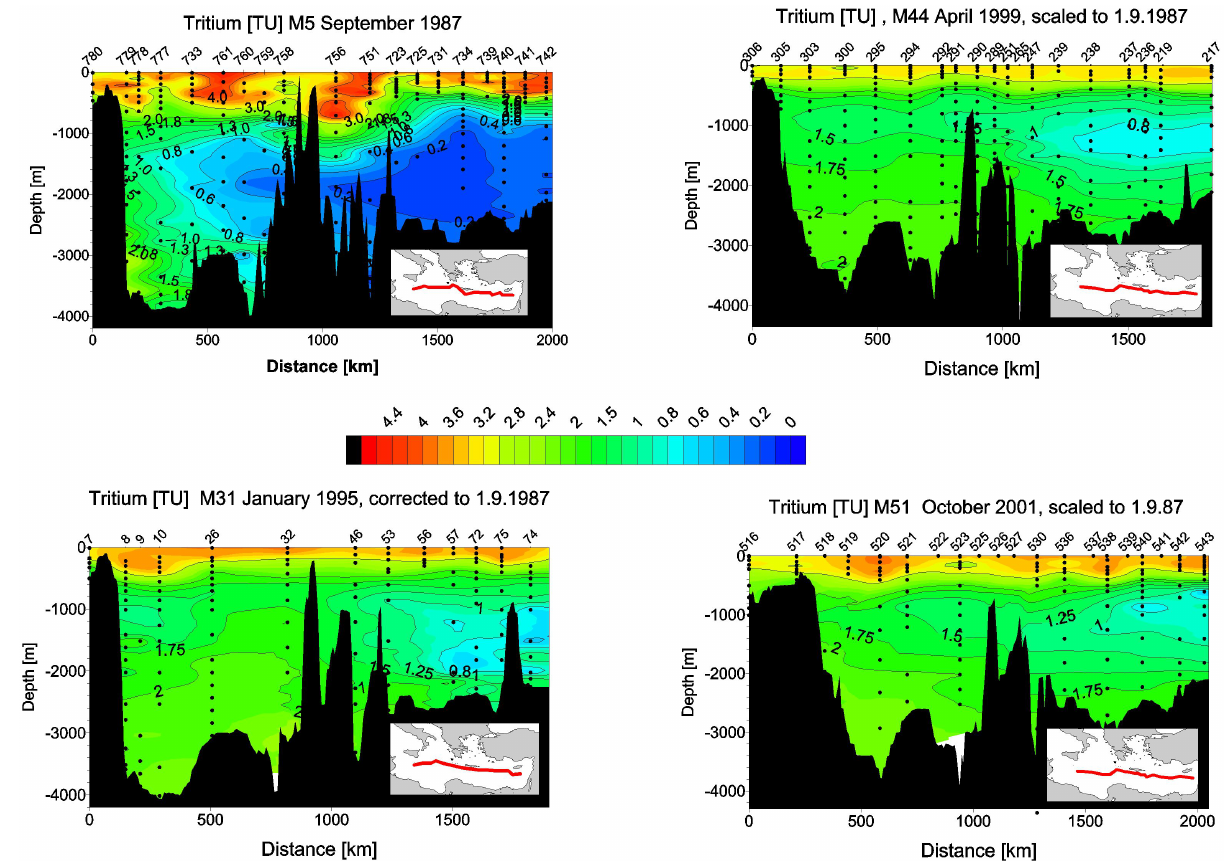
Fig. 2. Tritium sections (TU) of the Meteor cruises in 1987, 1995, 1999 and 2001 (cf. Table 1; for concentrations see colour bar and values at isolines), decay-corrected to the date of the 1987 cruise (1 September 1987; the factors are 1.51 for M31/1, 1.92 for M44/4, and 2.20 for M51/2). Numbers on top are station numbers, observations are indicated by dots, and the actual sections are shown in the inset maps. Isolines by objective mapping.